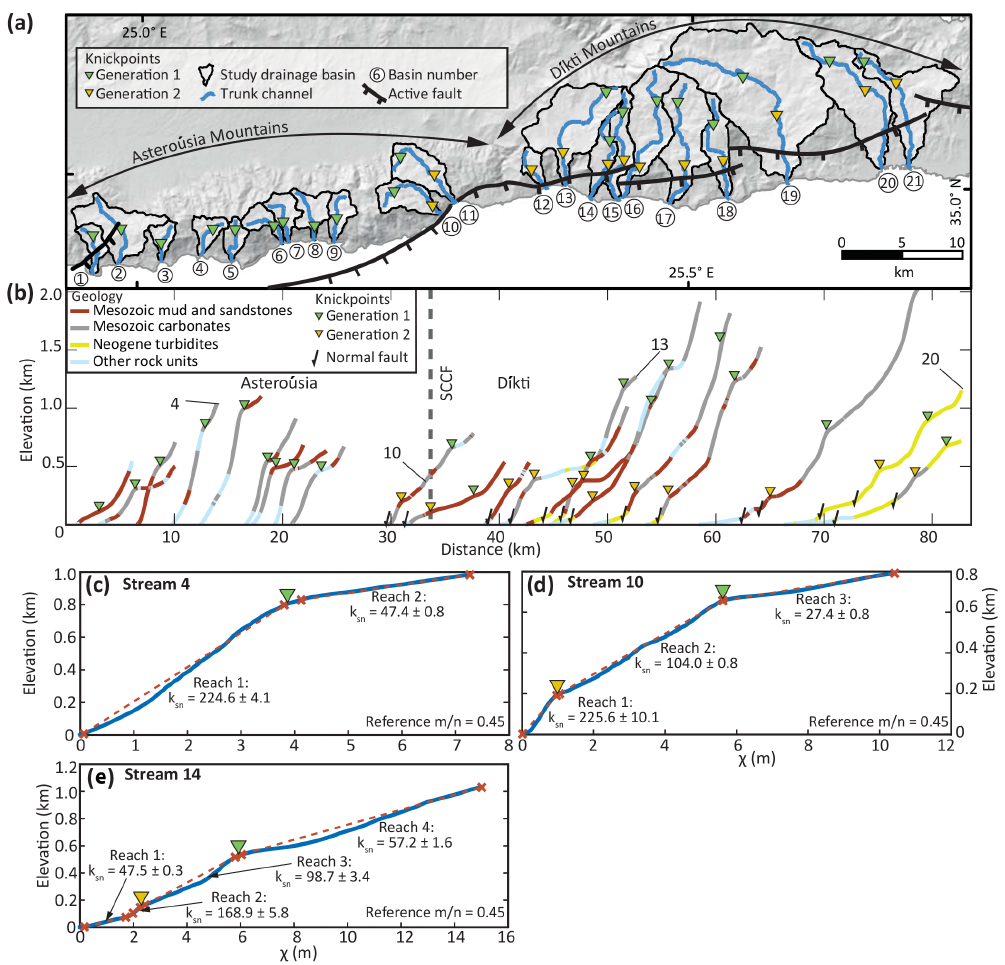
Figure 5. (a) Shaded relief map showing the location of the 21 drainage basins, trunk river channels, and fluvial knickpoints identified in this study. (b) Trunk channel river profiles for the 21 basins of this study plotted versus outlet distance from the town of Lentas. The rock type over which each river flows is shown as well as the major fluvial knickpoints identified during this study. (c–e) Typical examples of χ versus elevation plots for rivers in south-central Crete (thick blue lines). Knickpoints are shown as triangles and the dashed red lines show the linear regressions used to determine reach-specific normalized channel steepness index ( k sn